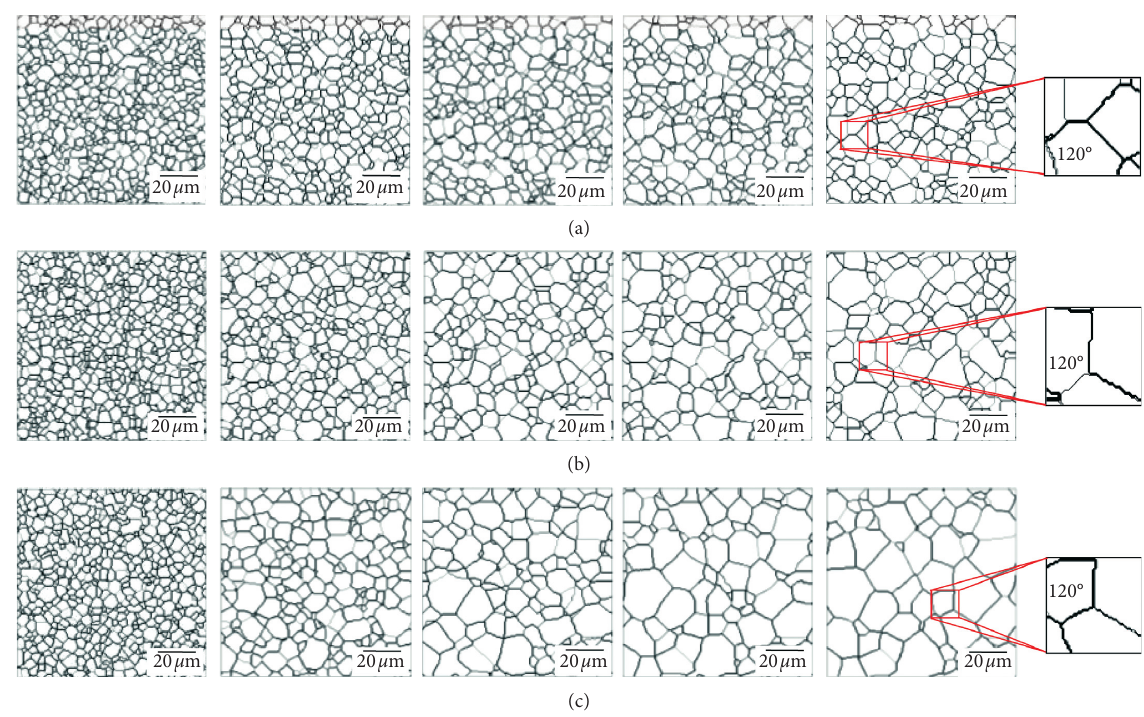
Figure 4: 3D grain growth slice at different temperatures: (a) 300 ° C, (b) 380 ° C, and (c) 420 °